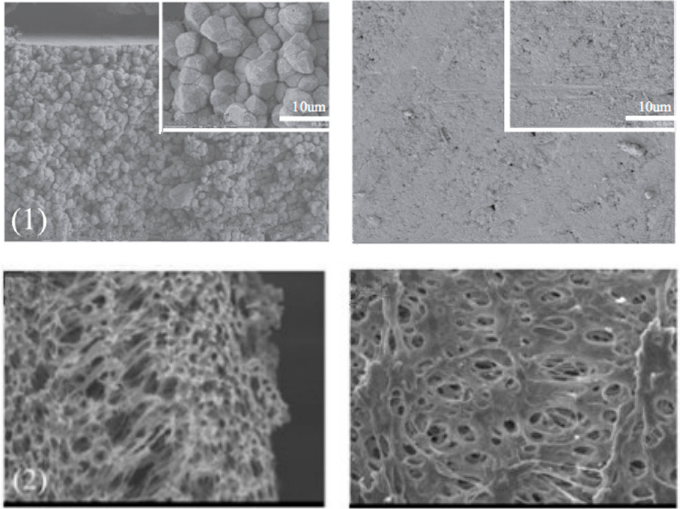
Figure 14. SEM images of cross-section and surface of ( 1 ) flat sheet; ( 2 ) hollow fiber ECTFE mem- brane [85,128].